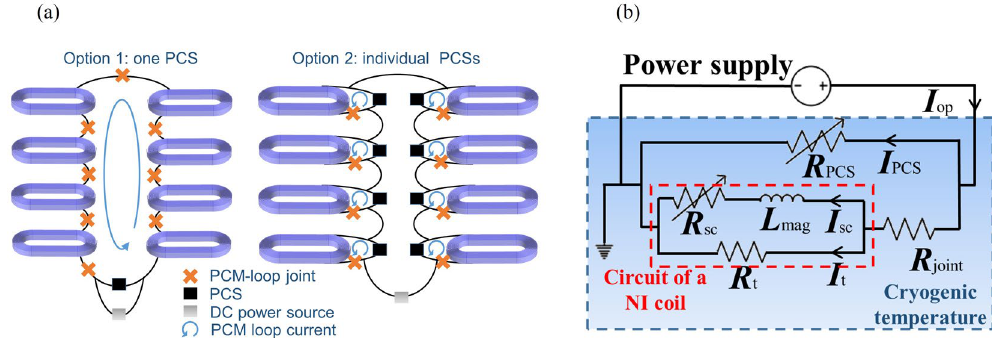
Figure 3. ( a ) Operations of PCS, i.e., one PCS for the whole or individual PCSs for each DP coil. And ( b ) the equivalent circuit model for a NI DP coil with its PCS. In the cryogenic environment, PCS is depicted by a temperature-dependent variable resistance R PCS . The lower branch has two parts, the left one is circuit of a NI coil 25 , and the right one is a joint (resistance R joint ) of two coil terminals. R t is the turn-turn resistance mainly controlled by winding tension and surface treatment of HTS wires. R SC is superconducting resistance depicted by ρ = E / J , where E and J relate as E–J power law (in Equation 1). L mag is the magnet